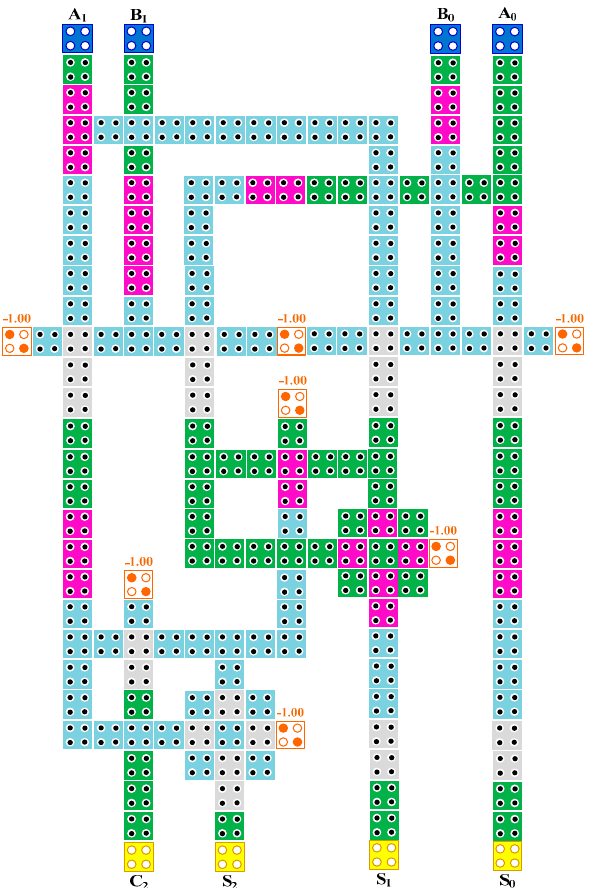
Figure 7. QCA design of the proposed 2 × 2 Vedic multiplier.